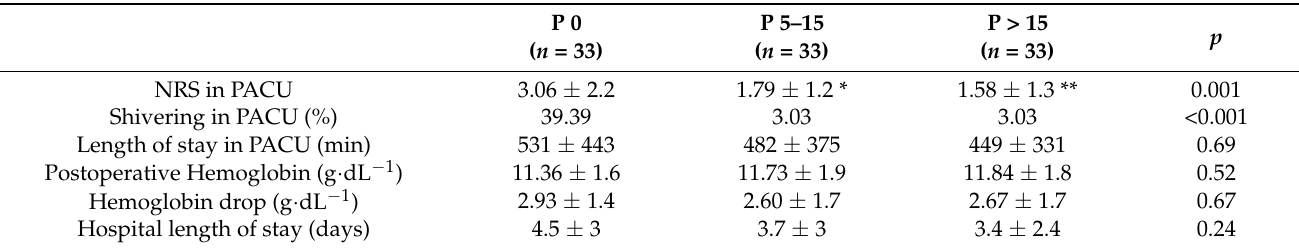
Figure 2. Mean perioperative temperature ( ◦ C) in the PACU in each group. PACU: Post-Anesthetic Care Unit; EndT: temperature at the end of surgery; T30PACU: temperature 30 min after admission to PACU; T60PACU: temperature 60 min after admission to PACU; P 0: non-pre-warmed; P 5–15: pre-warmed for 5–15 min; P > 15: pre-warmed for 15–30 min. * p < 0.01 vs. P 0; ** p < 0.0001 vs. P 0. Table 4. Postoperative evolution of patients in PACU, postoperative lab test, and complications throughout hospital stay and length of hospital stay.